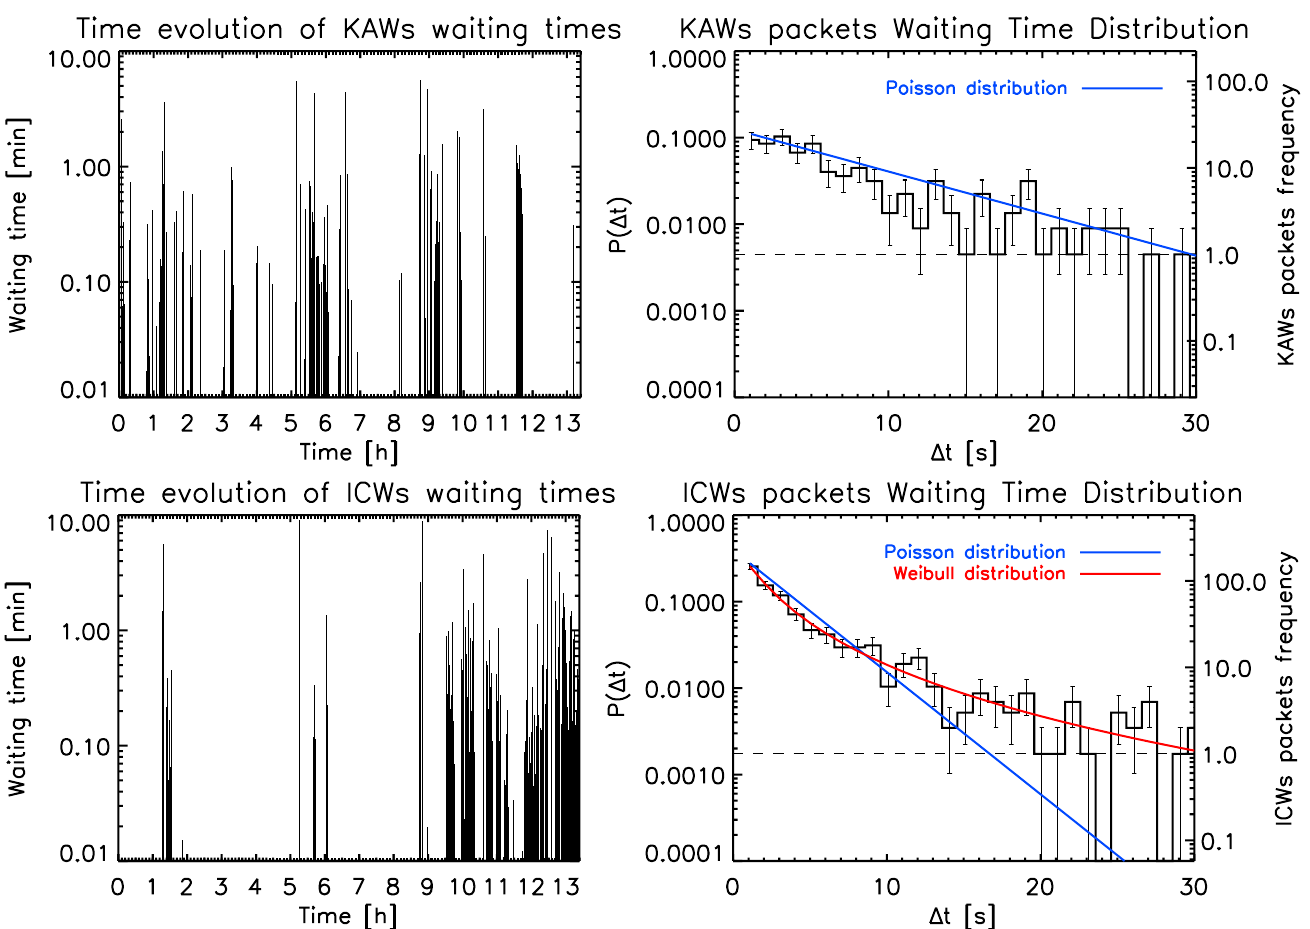
Figure 1. Sequence of the waiting times Δ 𝑡 at the event occurrence time (left panels) and corresponding WTDs 𝑃 ( Δ 𝑡 ) sampled in 1-second bins (right panels) for KAW (top panels) and ICW (bottom panels) packets; the corresponding theoretical Poisson distributions are displayed as blue curves; the ICW WTD is fitted by an exponentiated Weibull function (red curve), representing a persistent process with some memory generating correlations among the waiting times; the horizontal dashed lines refer to a frequency of occurrence equal to